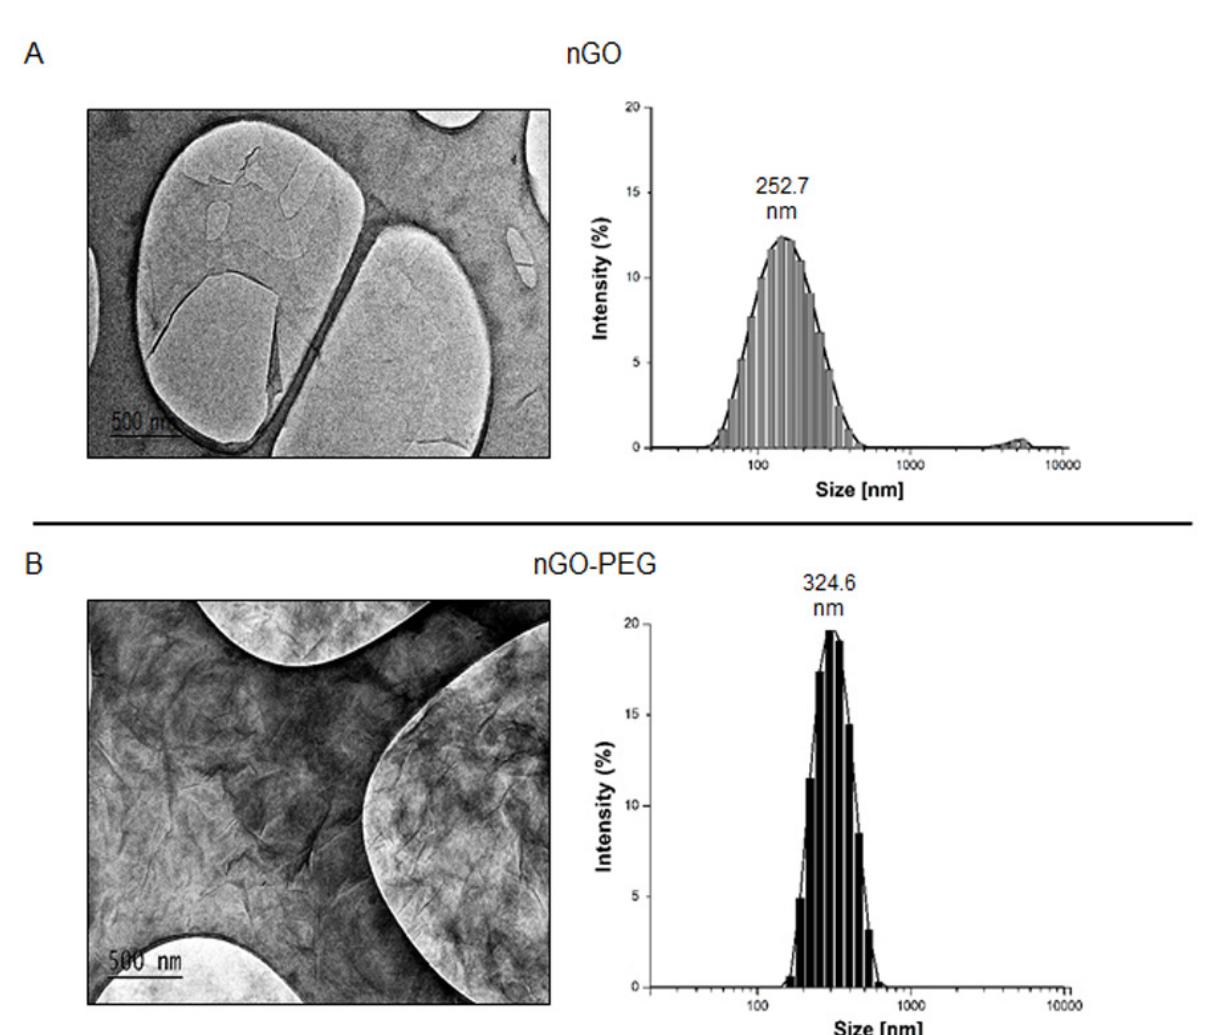
Figure 2. Morphology characterization and particles’ zeta size measurements of nGO and nGO-PEG. ( A ): Size and morphology of the nGO NPs: nGO morphology was studied on JEOL JEM-2100 high-resolution transmission electron microscope (HR-TEM) operated at 200 kV. The nanoparticles’ size was estimated by Zetasizer and results are presented by a histogram on the right panel. ( B ): Size and morphology of the nGO-PEG nanoparticles (NPs): nGO-PEG morphology was studied on JEOL JEM-2100 high-resolution transmission electron microscope (HR-TEM) operated at 200 kV. The nanoparticles’ size are presented by histogram on the right panel.